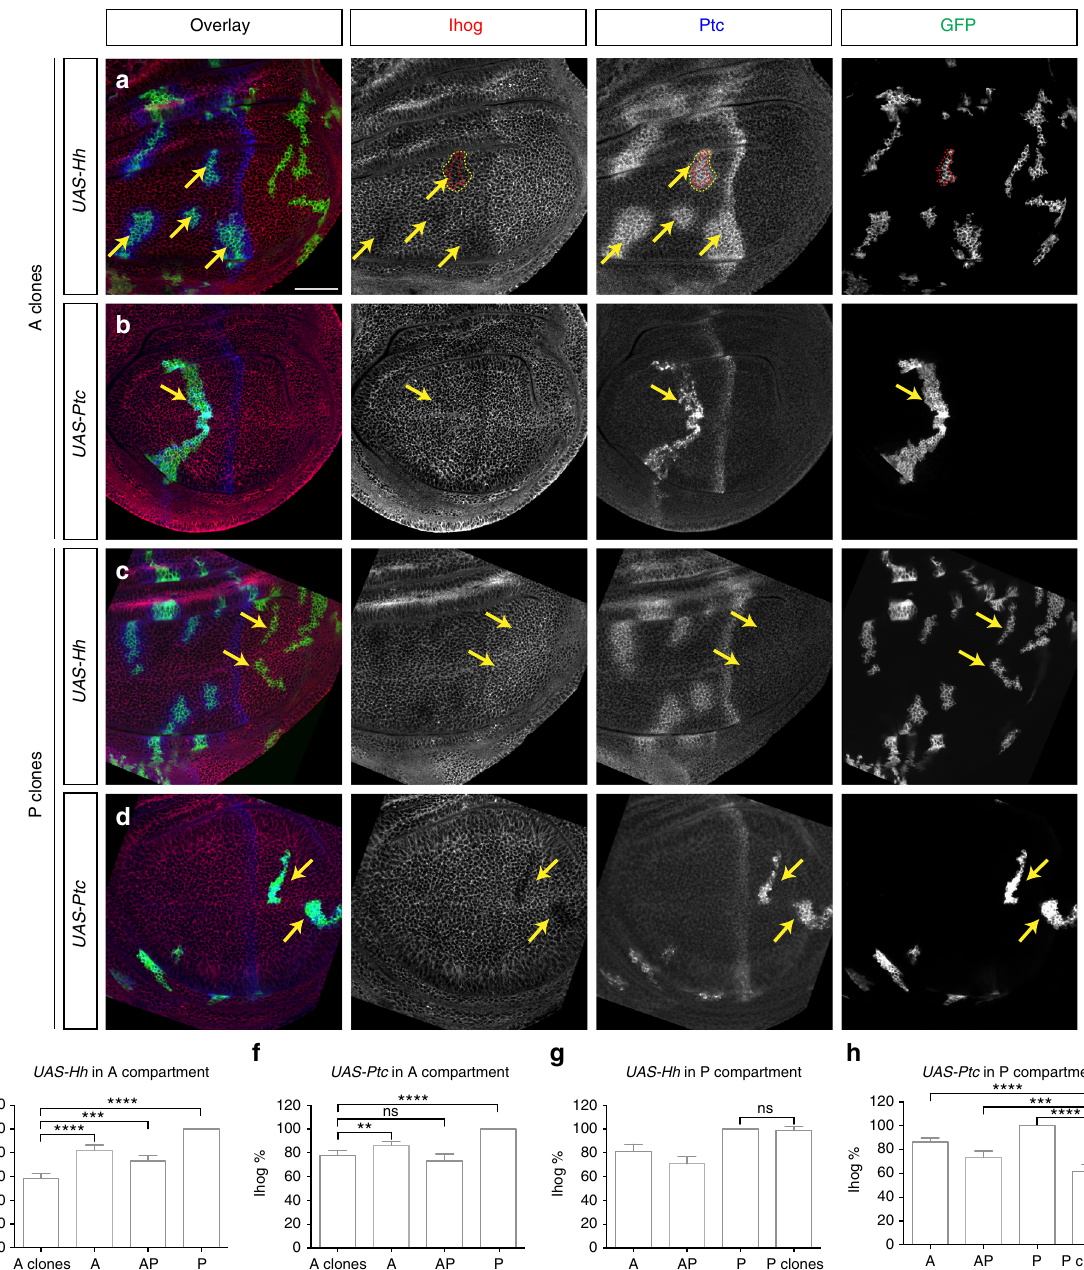
Fig. 6 Hh/Ptc-dependent modulation of Ihog protein levels in wing imaginal discs. Wing imaginal discs were immunostained with antibodies against Ihog (red), Ptc (blue), and GFP (green) proteins. a , c Activation of UAS-driven Hh expression in clones marked by expression of GFP (green). Ptc protein levels are increased in Hh-expressing cells and in nearby cells within the A compartment (arrows in a ), but not in the P compartment (arrows in c ). Reduced Ihog (red) levels are consistently detected in cells with elevated Hh and Ptc expression (arrows in a ). Note that the reduction of Ihog levels in A compartment extends beyond cells in the clone that express Hh (red lines in a ), but coincides with cells showing Hh-induced expression of high levels of Ptc (yellow lines in a ). b , d Activation of UAS-driven Ptc expression (blue) in clones marked by expression of GFP (green). Ihog is also slightly reduced in clones with elevated Ptc expression when located in the A compartment (arrow in b ) far away from Hh-producing cells. Ihog protein levels are markedly reduced in the Ptc-expressing clones located in the P compartment where Hh is highly expressed (arrows in d ). Scale bar, 50 µ m. e – h Quanti fi cation of Ihog intensity in clones marked by GFP and different compartments determined by Ptc staining in the wing discs. Ihog intensity at different location is normalized by that of P compartment of the same wing disc. Each bar shows the mean ± s.d. of normalized Ihog intensity from n = 10 wing discs, and representative images are shown in a – d . Two-tailed unpaired Mann – Whitney U -test was used for statistical analysis. ns, not signi fi cant. ** P < 0.01. *** P < 0.001. **** P < The incomplete effects of RNAi treatments on Ptc degradation ihog and boi in imaginal discs that constitutively express a low and phosphorylation of Smo are likely due to the fact that RNAi level of Ptc protein from the transgene, tubP-Ptc , in all cells 40 . Because the endogenous ptc gene is not expressed in posterior treatments in cultured cells (Supplementary Fig. 2A) are seldom compartment cells and because Hh expression in P cells is high, fully ef fi cient. To circumvent this dif fi culty and to examine no Ptc protein from the tubP-Ptc transgene could be detected in degradation of Ptc in vivo, we created mutant clones lacking both